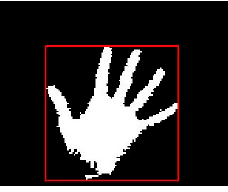
Figure 7. Noises be rejected by the area selection method.